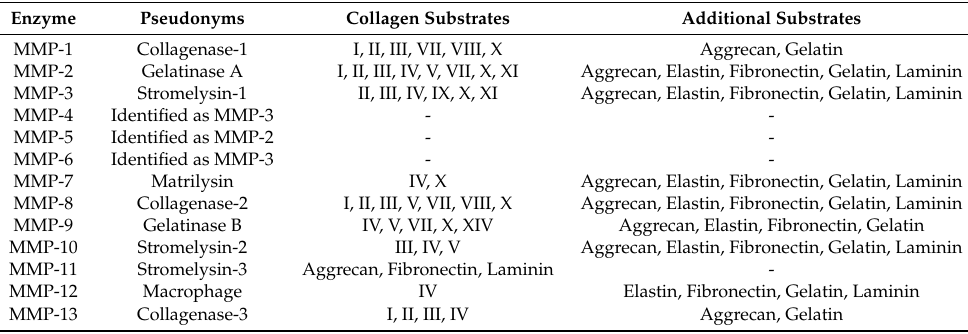
Table 1. The matrix metalloproteinase (MMP)